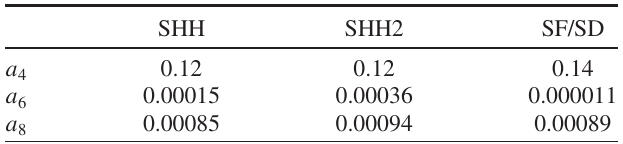
TABLE XIII. Systematic skew-multipole errors from the skew- quadrupole corrector coils in the sextupole magnets in units of the corrector skew-quadrupole field ( a 2 ¼ 1 ). The normal multipoles are